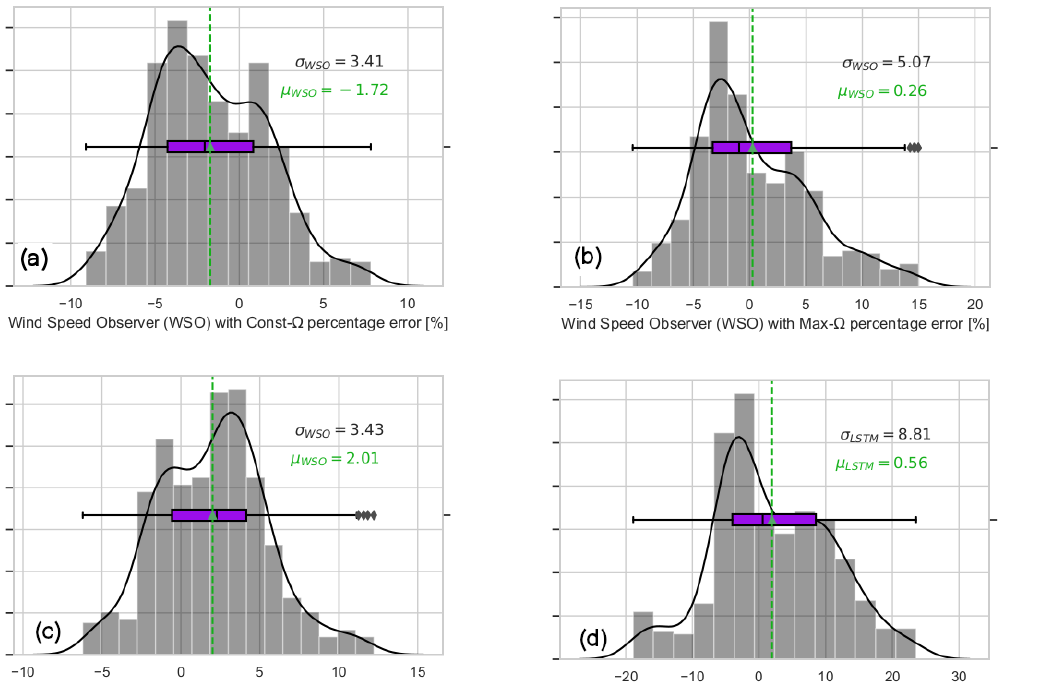
Figure 11. The 1Hz percentage error distribution of the available power estimation of the 10MW turbine for mean wind speed = 9ms − 1 and mean TI = 10%, the flow case represented in Fig. 7. The presented performances belong to the wind speed observer approach, presented in Sect. 2, under different operational strategies. (a) Constant rotational speed, Const.- (cid:127) ; (b) maximum rotational speed, Max- (cid:127) ; (c) minimum thrust coefficient, Min- C t , as 40% curtailment strategy; (d) LSTM model with transfer learning from lower wind speed to the higher wind speed case (no dependency on the curtailment strategy).